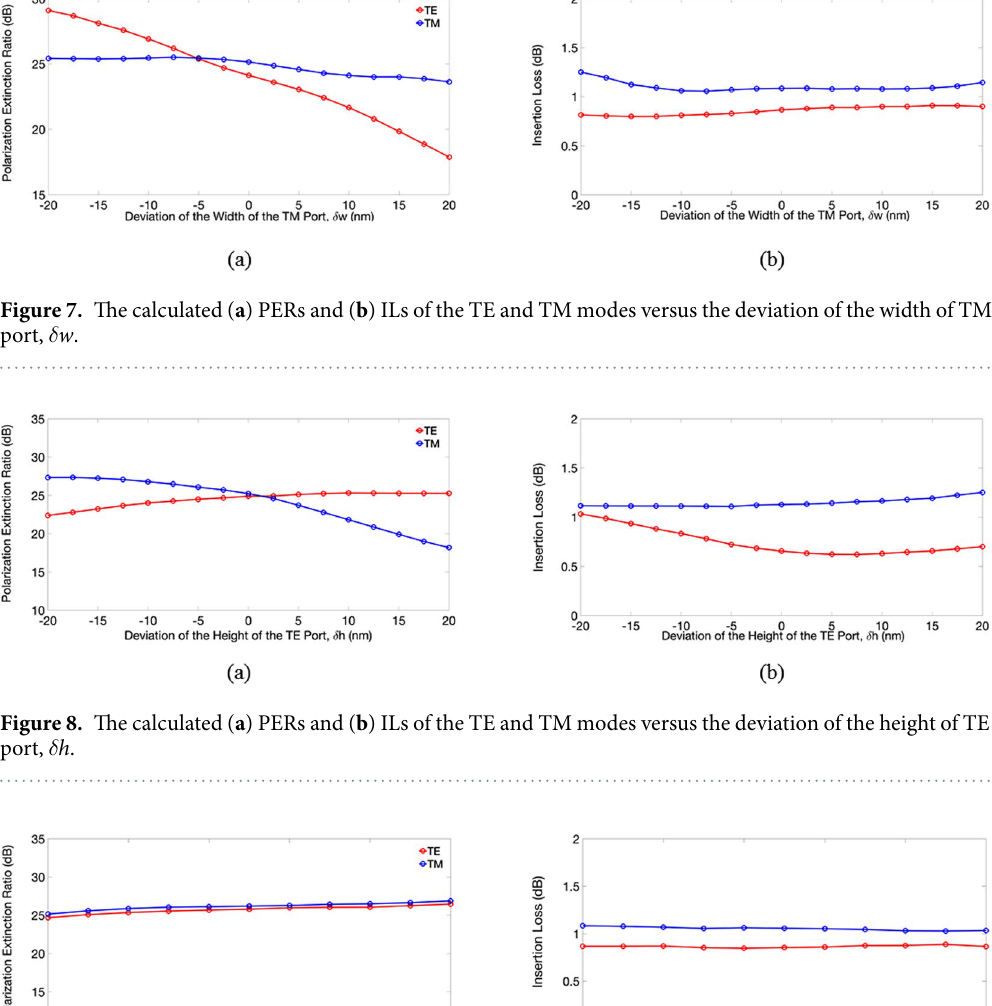
6 Scientific RepoRts | 7: 4531 | DOI:10.1038/s41598-017-05019-3